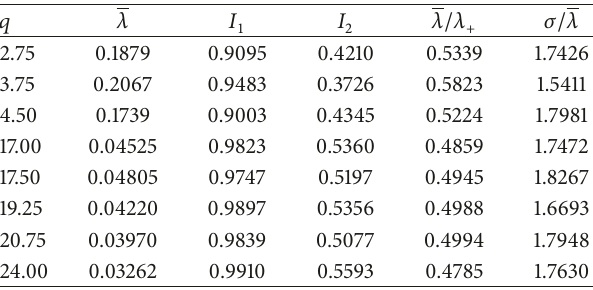
Table 2: Statistical parameters for | 𝜉 | = 10 −7 .